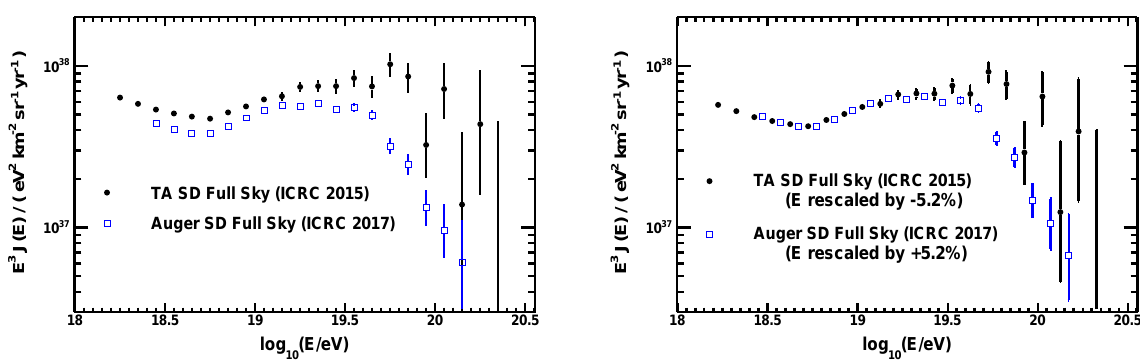
Figure 1. Energy spectra over the entire fields of view for TA [10] and Auger [5]: (left) calculated using the nominal energy scales of TA and Auger, (right) calculated after applying the overall + 5.2% (Auger) and -5.2% (TA) energy scale corrections. Significant di ff erence between the Auger and TA energy spectra remains after rescaling the TA and Auger energies by constant (energy-independent) factors.